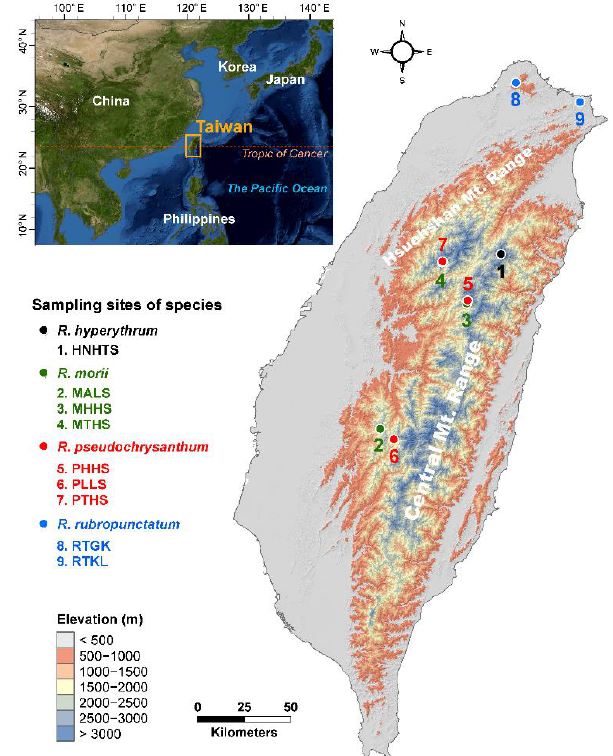
Figure 1. Geographic distribution of the nine populations of four closely related species in the Rhododendron pseudochrysanthum complex occurring in Taiwan. The countries’ boundary (polygon) map was derived from the default map database in ArcGIS v.10.3 (Supplementary Methods). The elevation gradients of Taiwan (background) were presented in ArcGIS based on the 20 m digital elevation model. The locations of the sampling sites were plotted using Tools in ArcGIS by their coordinates. See Table 1 for abbreviations of the nine populations of the R. pseudochrysanthum complex.